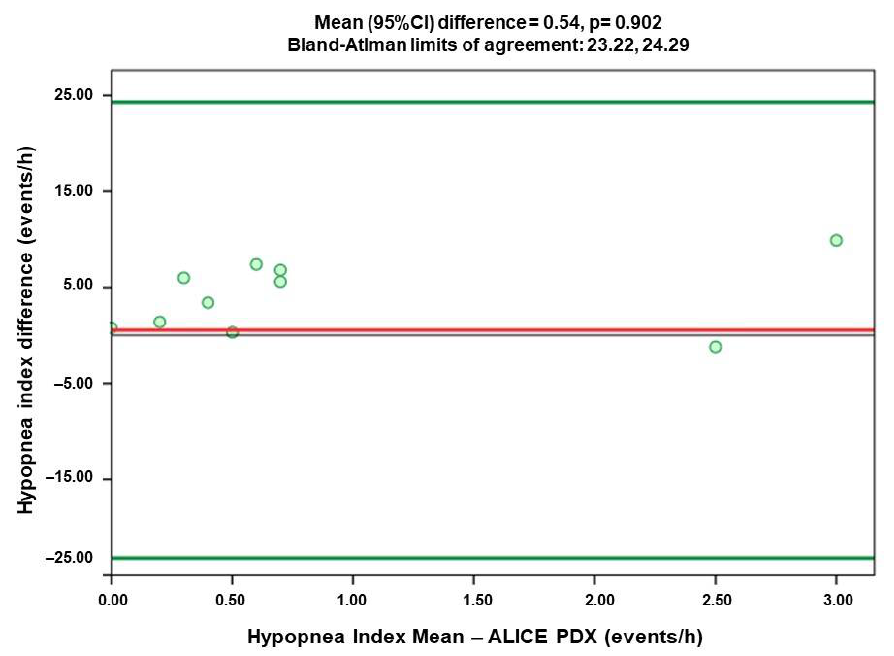
Figure 5. Bland-Altman plots. Distinction between the HI-Alice PDx plotted against the two devices’ HI difference ( n = 11). The red line presents the mean difference, while the green ones present the limits of agreement. HI: hypopnea index.